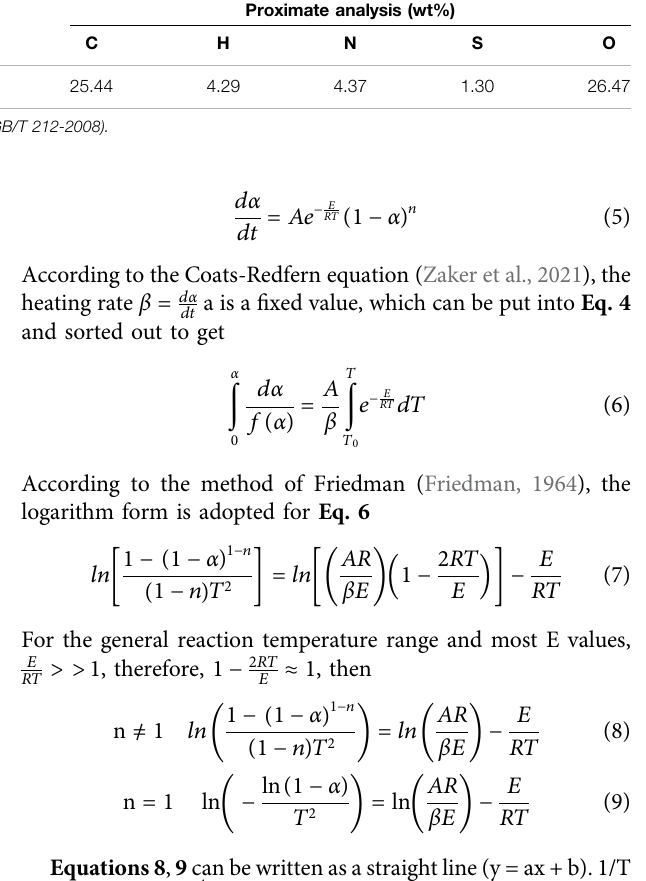
TABLE 1 | Characteristics of bagasse and sludge on a dry basis. Samples